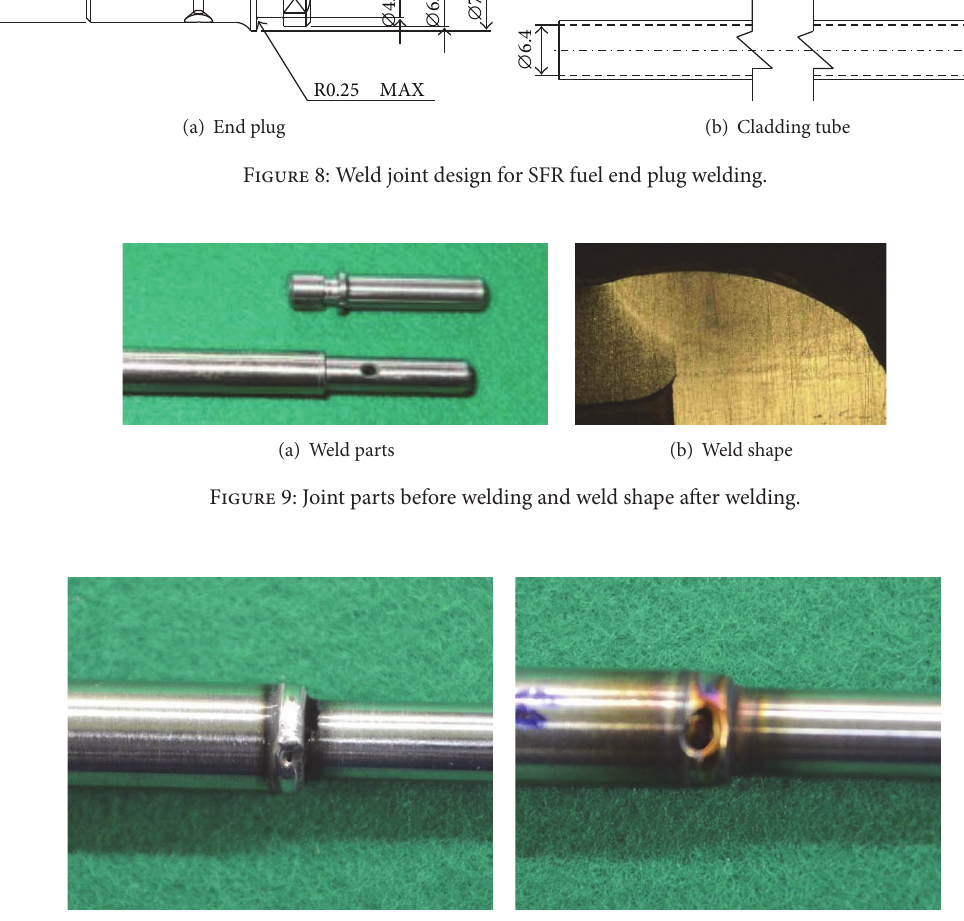
Figure 10: Weld defects in the end plug